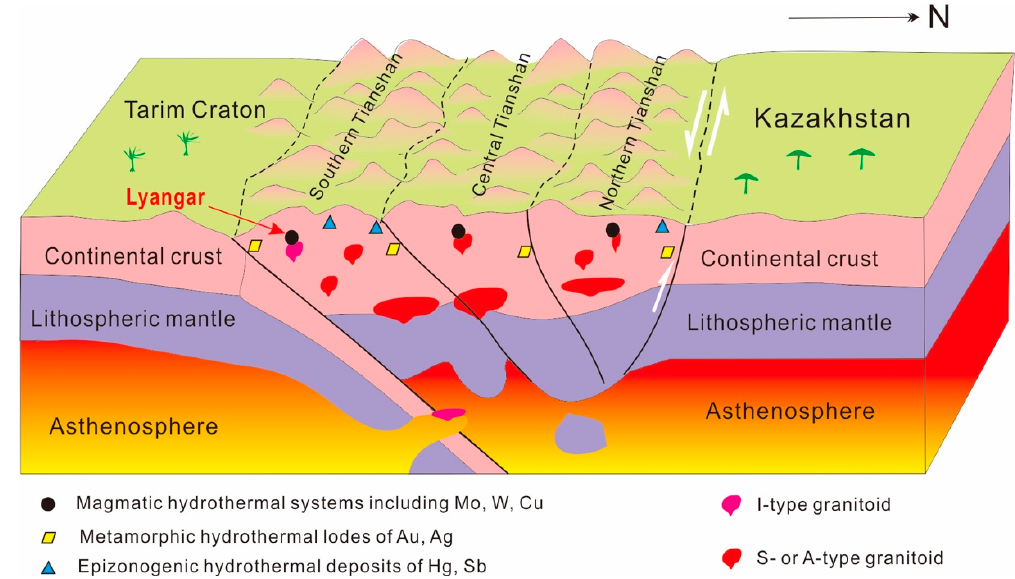
Figure 5. Schematic diagram for the tectono-magmatic-metallogenic setting in Permian South Tianshan Orogen (Base map modified after [3]).